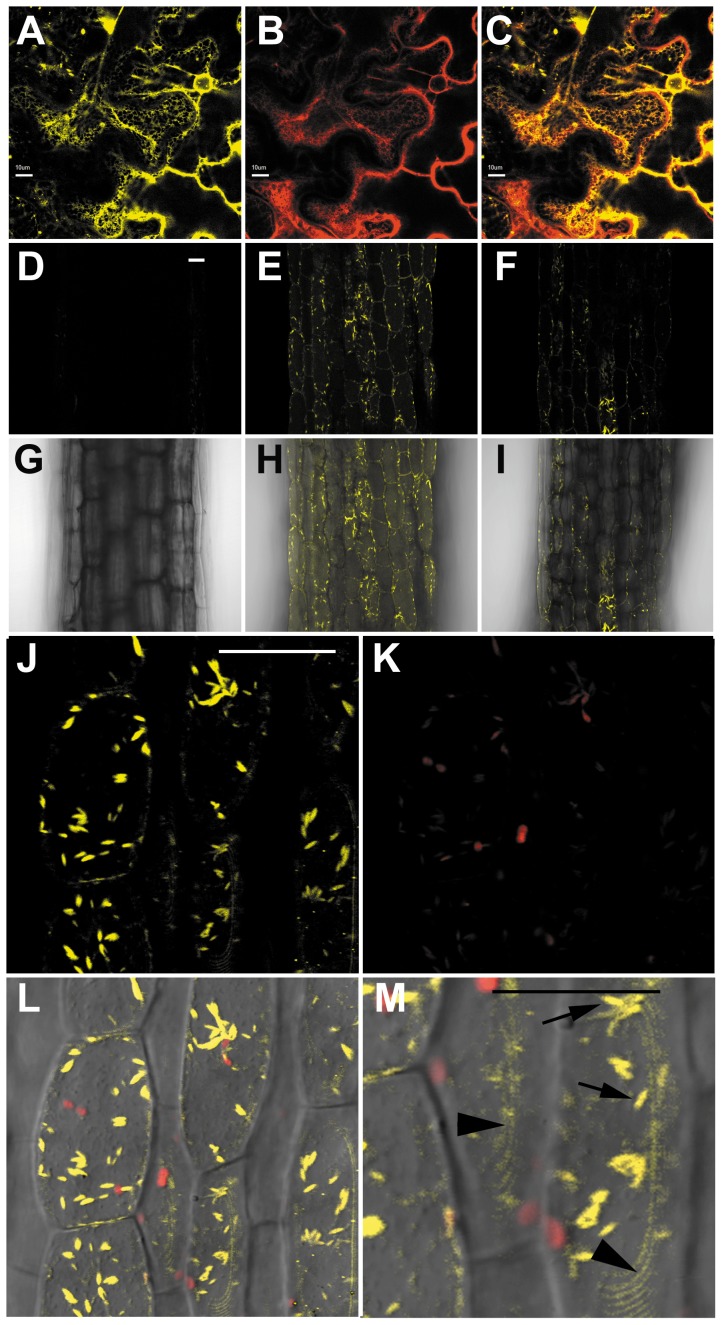
PLAT1 is localised to the ER in Arabidopsis and Nicotiana benthamiana.Transient transformation of the PLAT1:PLAT1-YFP construct to N. benthamiana. YFP channel showing PLAT1-YFP expression (A), RFP channel showing ER-rk CD3-959 mCherry marker expression (B), co-localisation of PLAT1-YFP with the ER-rk CD3-959 marker (C). PLAT1 expression in stable plat1-1 transgenics (line YFP13-1) rescued by the PLAT1:PLAT1-YFP rescue/reporter construct (D-I) 48 h following transfer of 3-d-old seedlings to control, NaCl or ABA plates, with YFP channel (D-F) and merged YFP and bright field channels (G-I). PLAT1 expression following transfer to control medium (D, G), following transfer to 200 mM NaCl (E, H), and expression following transfer to 1.5 µM ABA (F, I). Hypocotyl section from line YFP13-1 with YFP channel showing PLAT1:PLAT1-YFP reporter activity (J), red autofluorescence of chloroplasts (K), merged image of bright field, YFP and red autofluorescence (L). (M) Detail of (L), showing PLAT1 localisation to putative ER bodies (arrows) and the ER (arrow heads). Scale bar = 10 µm (A-C), 0.1 mm (D-L), 0.05 mm (M). n≥10.